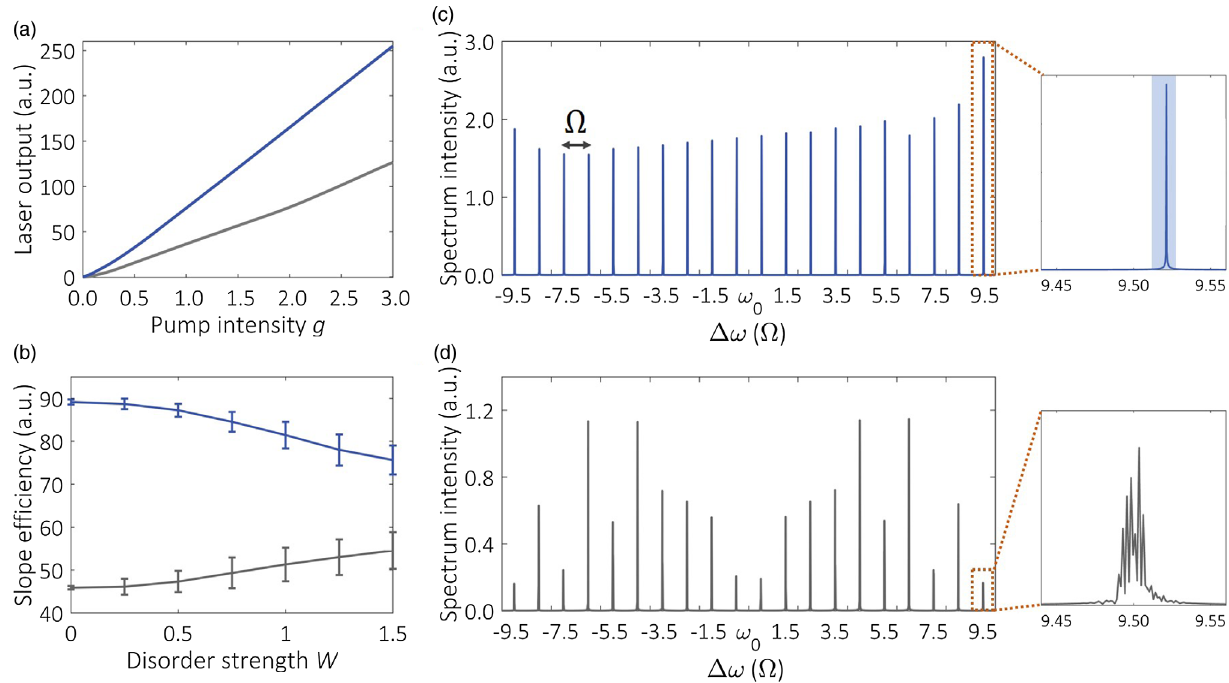
FIG. 2. Laser output versus (in arbitrary units, arb. units) pumping intensity and the spectra of the topologically nontrivial and trivial lasers. (a) The total output power versus pumping intensity. The slope efficiency of the topological laser is about twice that of the trivial laser. (b) Slope efficiency versus disorder strength. The on-site disorder is composed of independent random variations in the resonance frequencies, uniformly distributed in ½ − W; W (cid:2) , where W is in the units of t 0 . This panel presents the mean of 100 realizations of disorder for every point of disorder strength. (c),(d) Frequency spectra of the topologically nontrivial (c) and trivial (d) lasers, as emitted from the connecting side resonator on the right-hand side; the panels on the right show the enlarged spectra around 9 . 5 Ω . The topological system emits a comb of narrow single frequencies, whereas the trivial system has multiple modes around each central frequency. The original resonances in each ring are set to be − ð M − 1 = 2 Þ Ω ; … ; ð M − 1 = 2 Þ Ω centered at ω 0 ( Ω ¼ 100 is the free spectral range, M ¼ 20 is the number of modes in each ring; ω 0 is set to 0 for simplicity). The topological landscape causes a constant shift to all the resonance frequencies by a value of 0 . 019 Ω , as shown by the shift from 9 . 5 Ω in the enlarged spectrum in (c) (see explanation in Sec. A in Supplemental Material [59]). The blue and gray curves represent the topological and trivial lasers, respectively. The blue shaded region on the right in (c) indicates the topological band